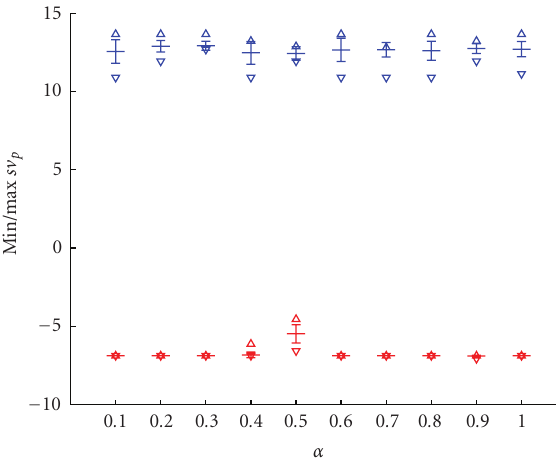
Figure 4: Variance of the minimal and maximal percentage of the initial signal increase sa i for 20 runs in function of the initial steps size α varied from 0.1 to 1. As an optimal value, we obtain α = 0 . 3.